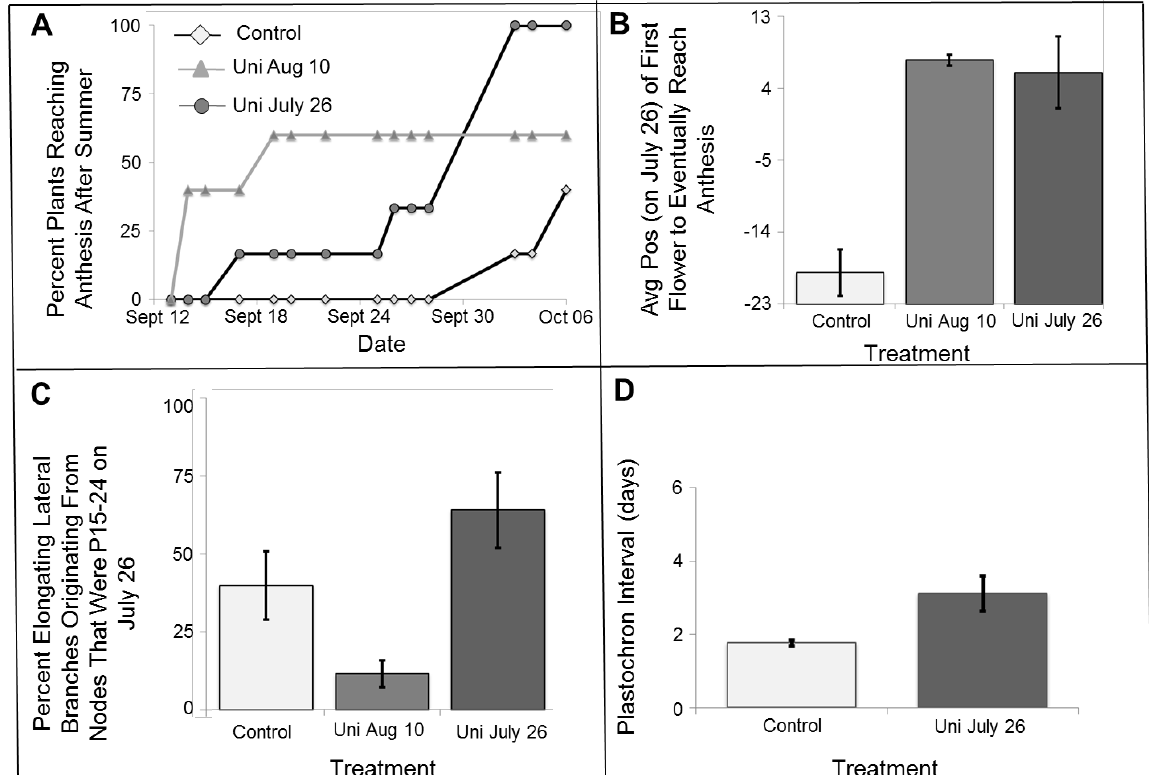
Figure 3. Uni application on one-branched pot-grown PD plants (2010). The plants were grown under local end of summer conditions, in a net house (see Section 3.3). Treatments: plants sprayed with 200 ppm Uni on July 26 (DOT) or on August 10. Control plants were sprayed with water plus surfactant at DOT. Six plants were analyzed for each